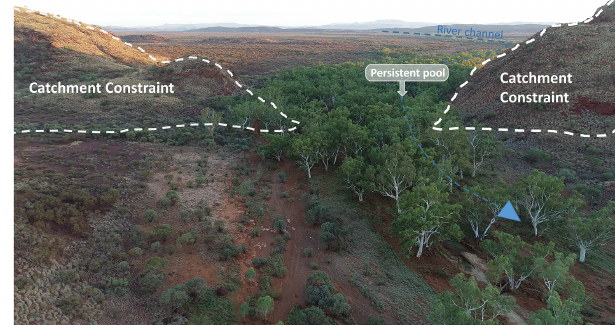
Figure 6. Photo showing a river pool that persists where a surface catchment is constricted, resulting in a groundwater